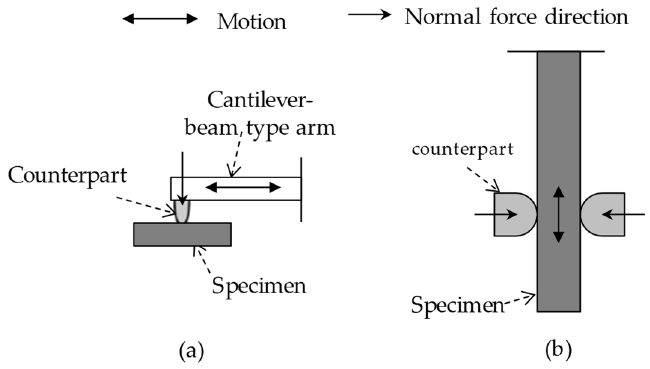
Figure 3. Typical rigs for a fretting wear test: ( a ) A cantilever-beam type; ( b ) An in-line type.